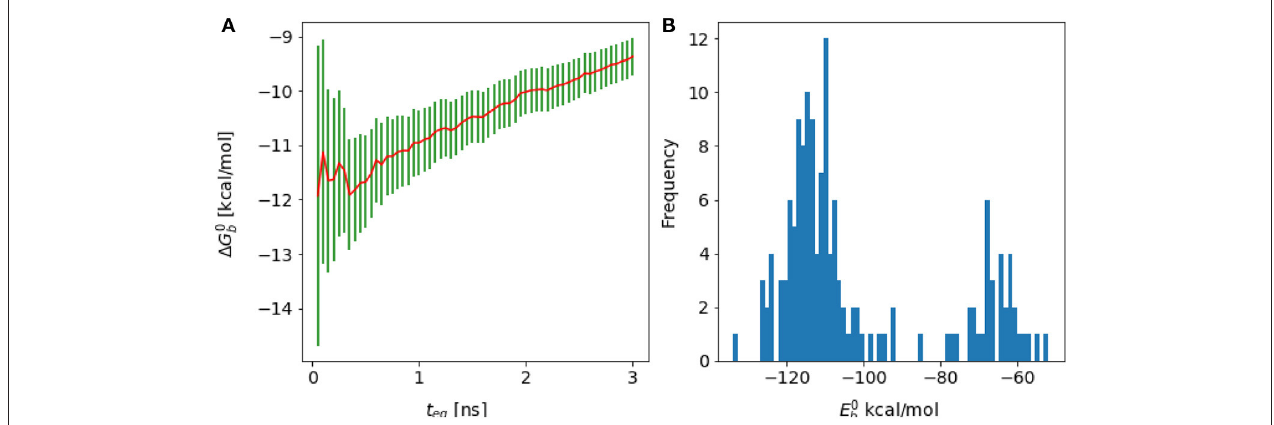
FIGURE 11 | (A) Forward cumulative plot and (B) histogram of the binding energy distribution at λ the linear